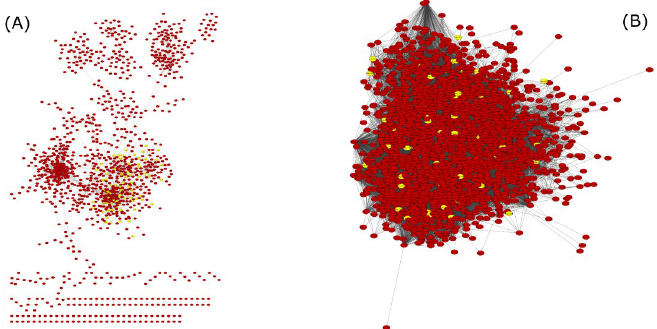
Fig 3. L . lactis MG1363 GCN visualized in Cytoscape v3.2.0. A: GCN generated using SPACE ( ρ = 0.68). Projection of genes (shown in yellow) associated to significantly enriched GO groups in “module 0”, other genes are colored red. The network consists of 1262 genes and 4112 edges. Only genes that satisfied the association threshold levels for inclusion in the adjacency matrix are shown in the network. B: Example network of L . lactis MG1363 generated using GeneNet ( ω = 0.90; 2235 genes and 70386 edges). For instance, the GCN obtained using SPACE has enriched gene sets in “module 0”, which are clustered together in the network (enriched gene sets in yellow), while the same genes are spread out in the GeneNet